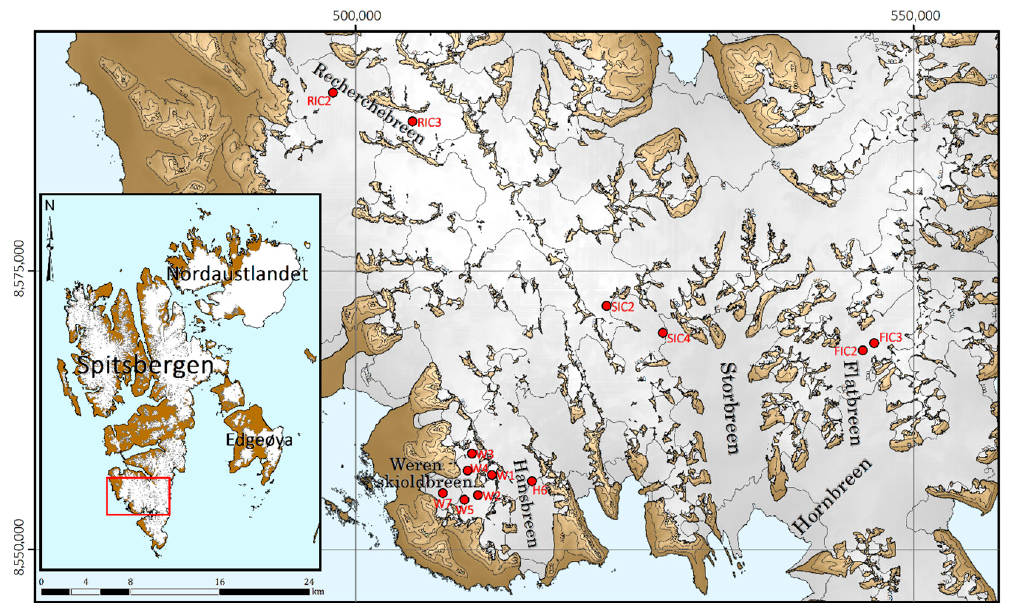
Figure 1. Map with coring sites (see Tables 1 and 2 for details). Red dots mark cores investigated in this study. Source: Map data © Norwegian Polar Institute, version: September 2017. Table 1. Selected details for glaciers sampled in this study. ELA, Equilibrium Line Altitude. Glacier